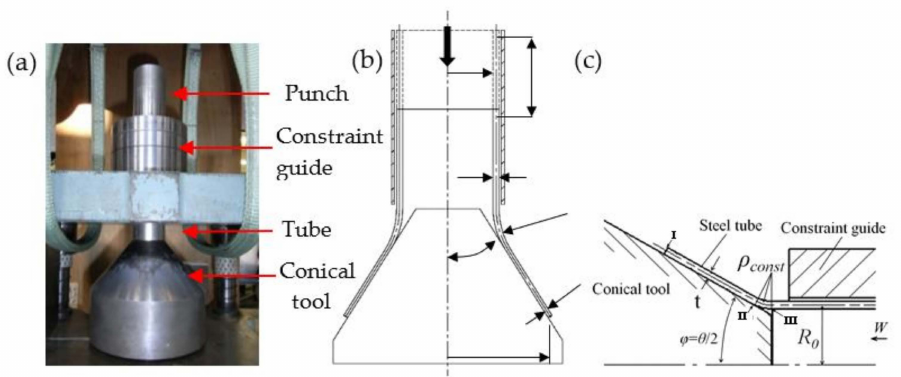
Figure 1. ( a ) Experimental devices, ( b ) schematic illustration and ( c ) detailed view of the schematic illustration of the deformation part of tube in the flaring